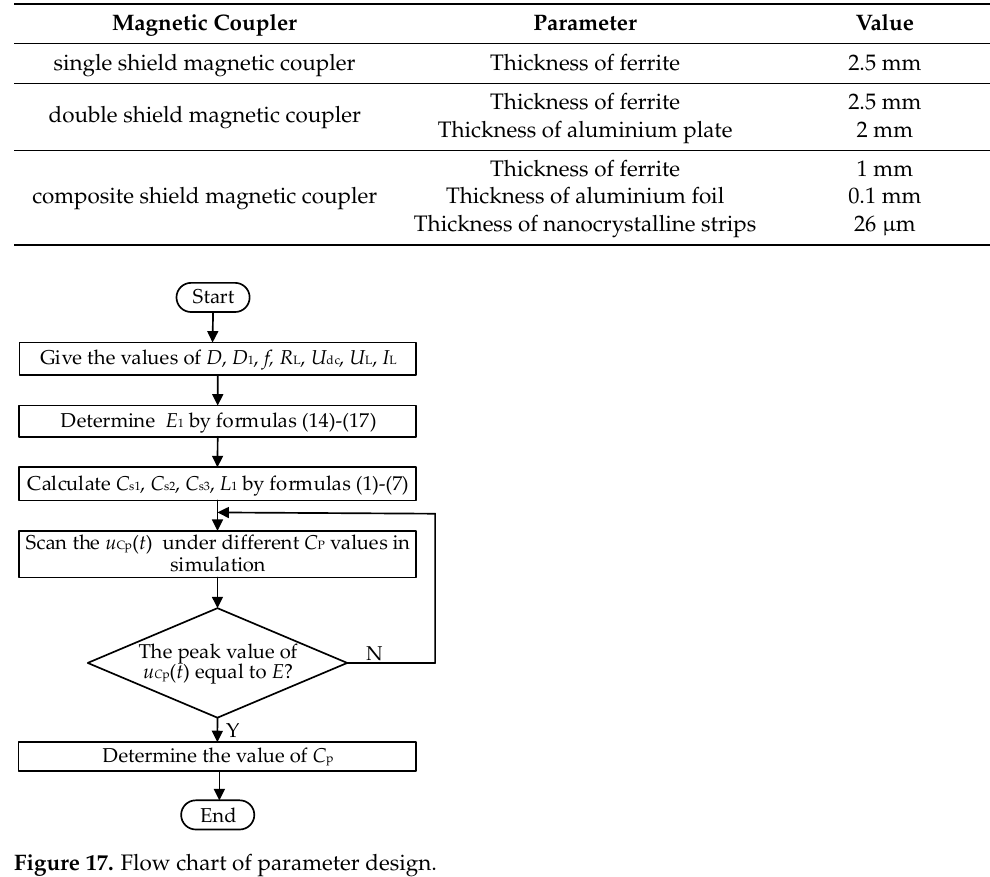
Table 1. Parameters of different types of shielding structures for receiving coil.